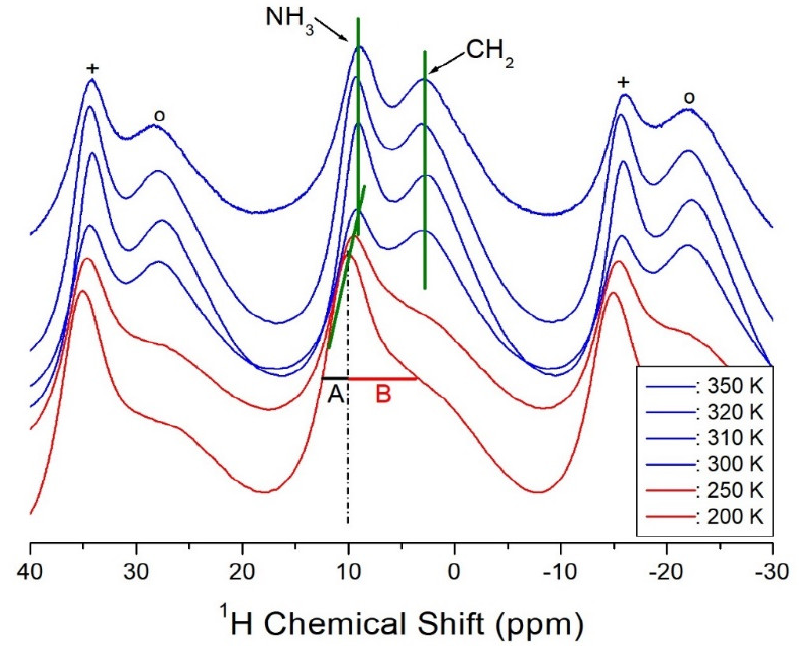
Figure 7. 1 H NMR chemical shifts of [NH 3 (CH 2 ) 5 NH 3 ]MnCl 4 at 200, 250, 300, 310, 320, and 350 K. + and o are the spinning